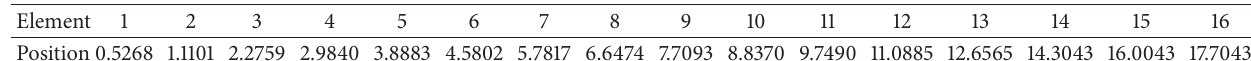
Table 12: Geometry of 32-element (with respect to 𝜆 /2) LAA obtained using EFPA.